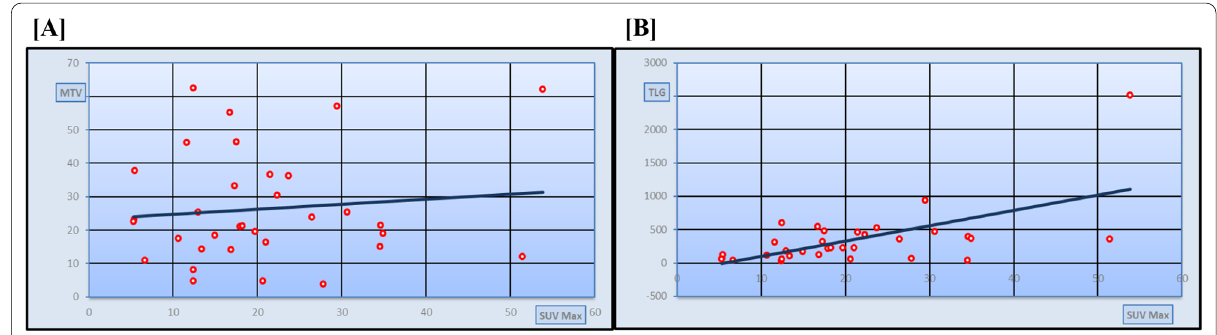
Fig. 1 The correlation between SUVmax and the metabolic parameters